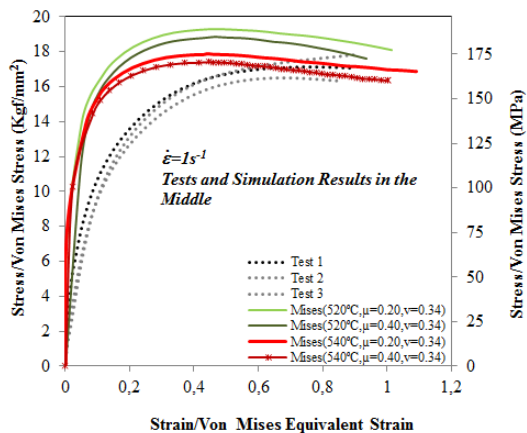
Figure 7. True stress vs. True strain curves from experiments (dotted lines), and Von Mises Stress vs. Von Mises Equivalent Strain curves in the middle of the sample from simulations (solid lines), all of them for tests at 540 °C and strain rate of 1s -1 .